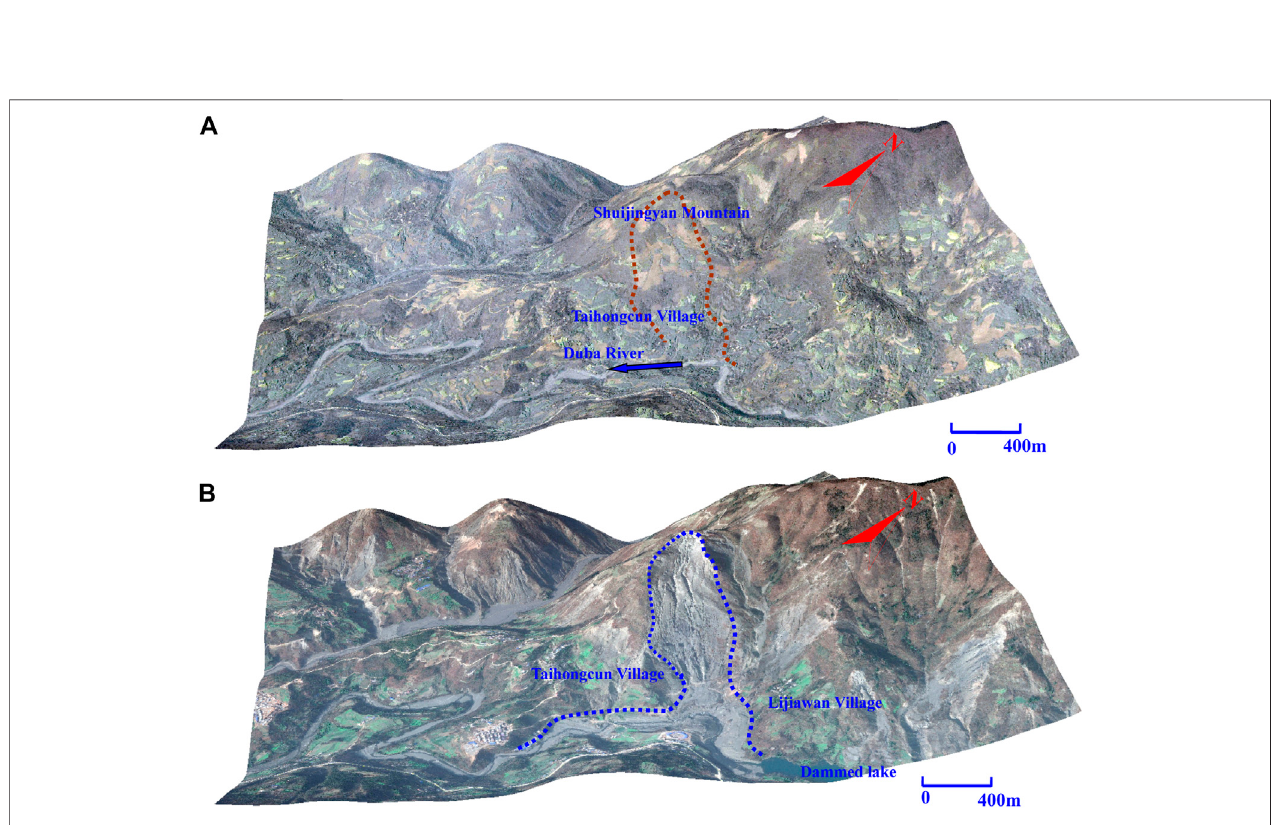
FIGURE 2 | (A) Pre-sliding image from Google Earth taken on April 2, 2005; (B) Post-sliding image from Google Earth taken on January 22, 2011.